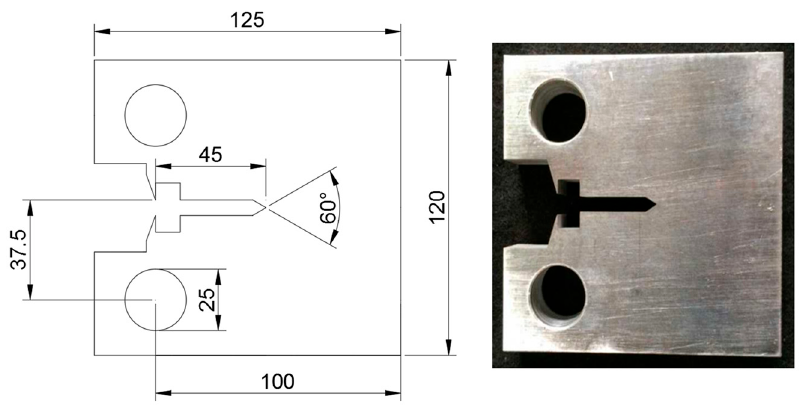
Figure 4. Dimensions of the compact tension (CT) specimen for the fracture toughness test (unit: mm).